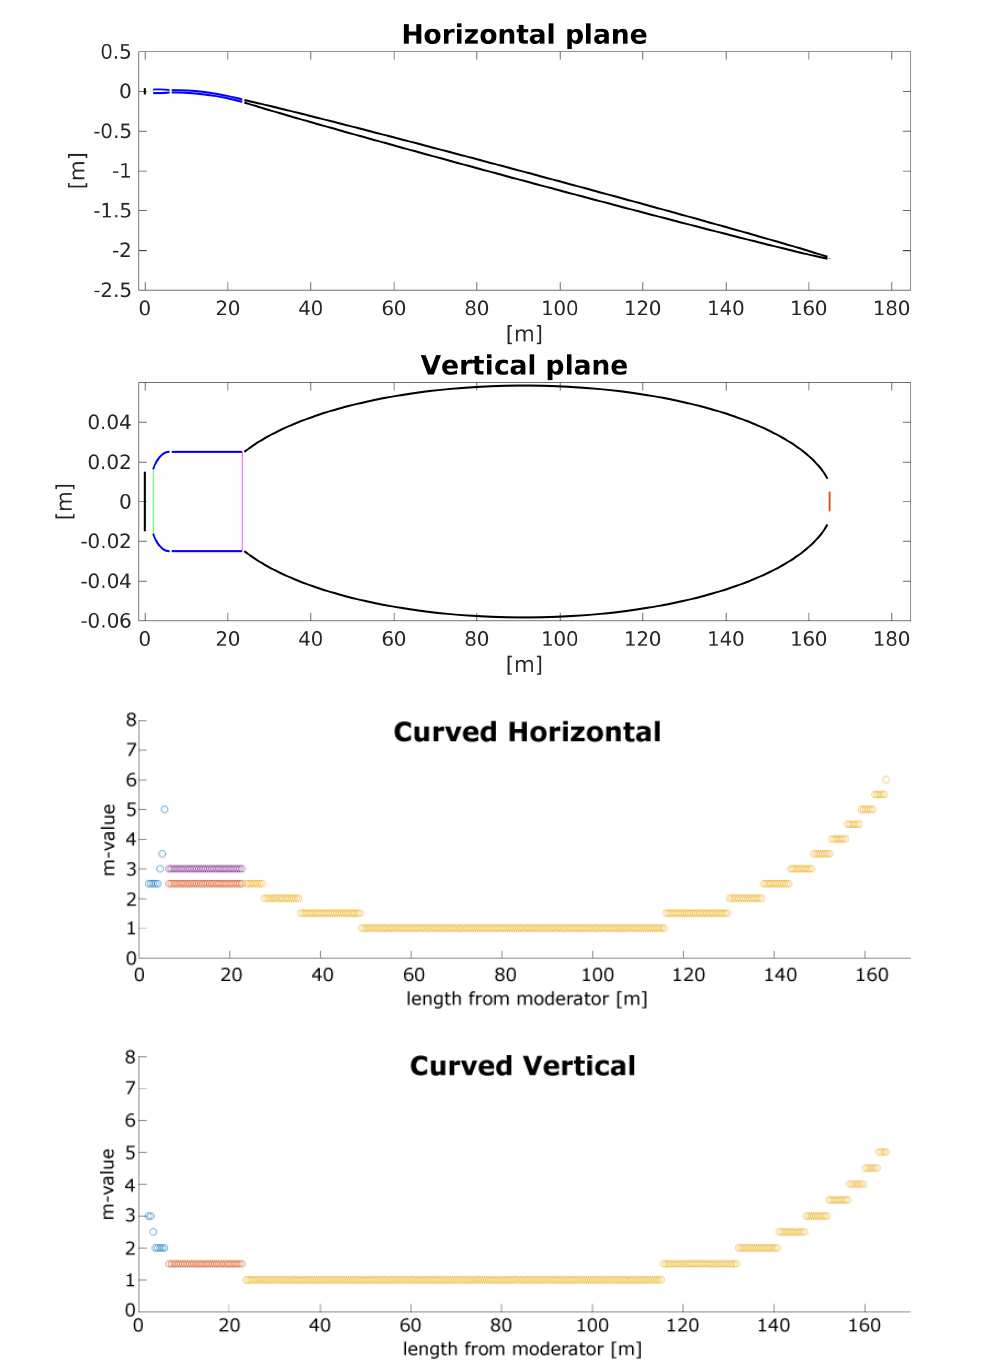
Figure A6. Curved guide. Guide dimensions and coating values. Top panels: Schematic drawing of the curved guide, optimized for the wavelength band 1.5–4.0 Å. The figures are not to scale. Bottom panels: The optimized m-distribution in the horizontal and vertical directions, respectively. The left side (purple) of the curved section has a slightly high m-value than the right side